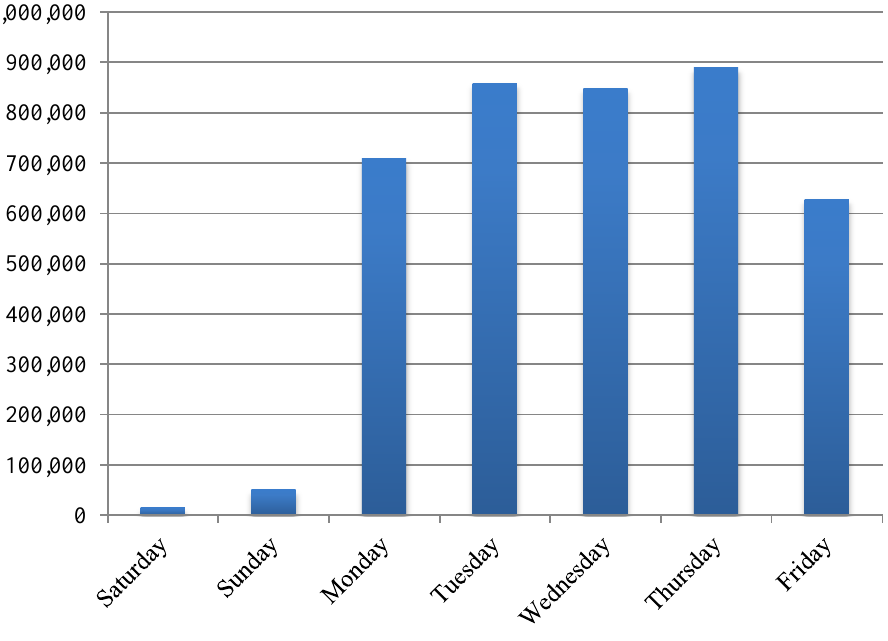
Figure 2. Total counts of new stories by day of the week from 1 January 2003 to 31 October 2012. The numbers of news on Saturday and Sunday are much less than on weekdays.